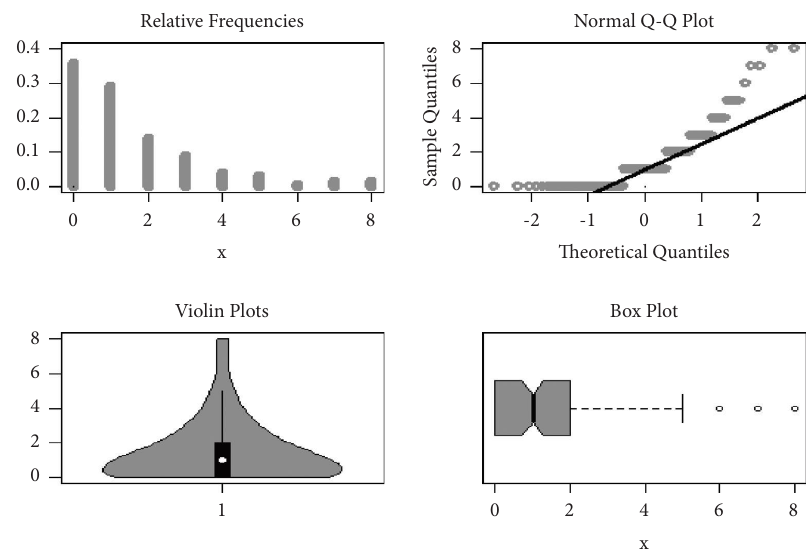
Figure 3: Data set I visualizations. Table 10: Te MLE, SE, and CI of the tested models based on data set